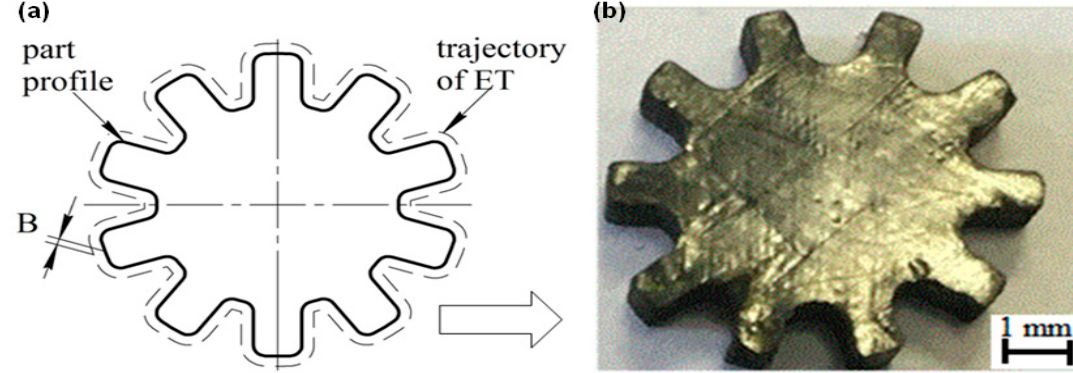
Figure 12. ( a )Trajectory of the ET, and( b ) finished